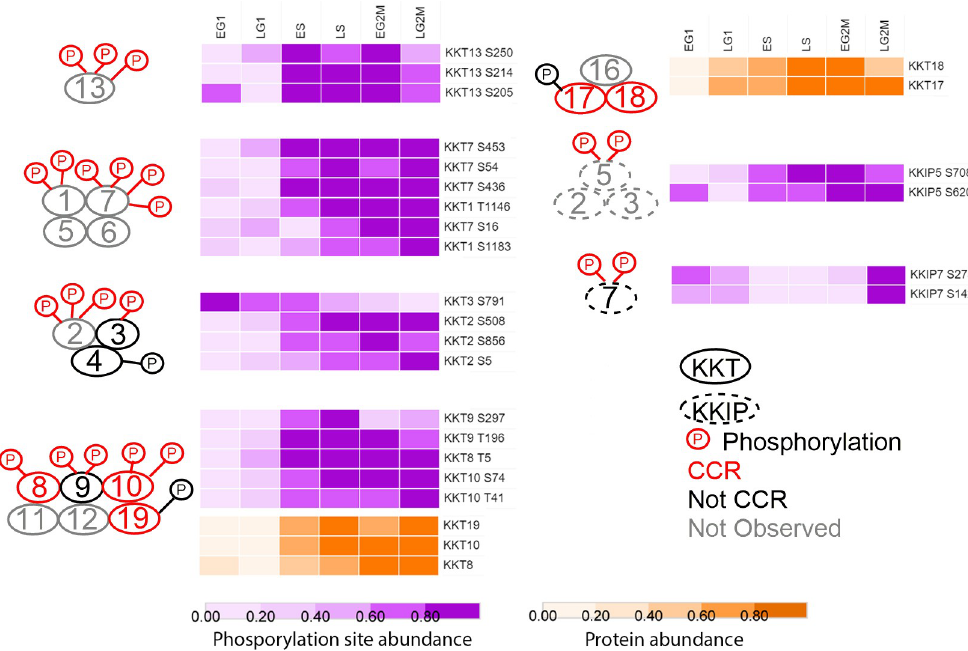
Fig 6. Phosphorylation of the kinetochore is temporally regulated. Schematic of predicted kinetochore proteins complexes [38], with CCR phosphorylation sites and proteins rendered as a heat map of fold change scaled to the unit integer. KKT–kinetoplastid kinetochore; KKIP–kinetoplastid kinetochore interacting protein; red–CCR; black–not CCR, grey–not